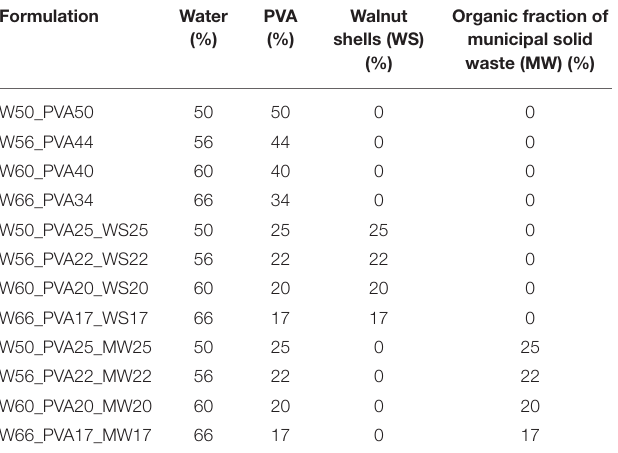
TABLE 1 | Compositions of all the produced formulations. Formulation